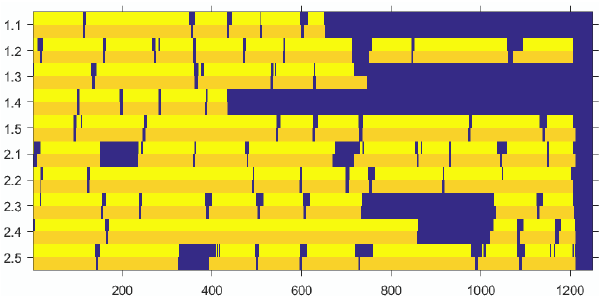
Figure 8 . Performance of ITop and I2MC on